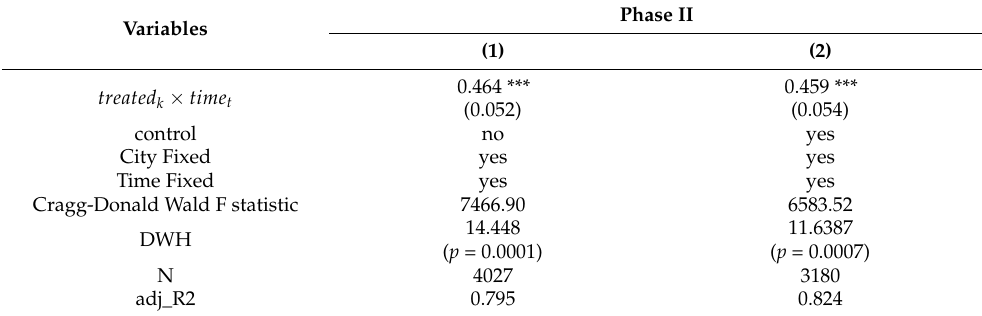
Table 3. Instrumental variable method.